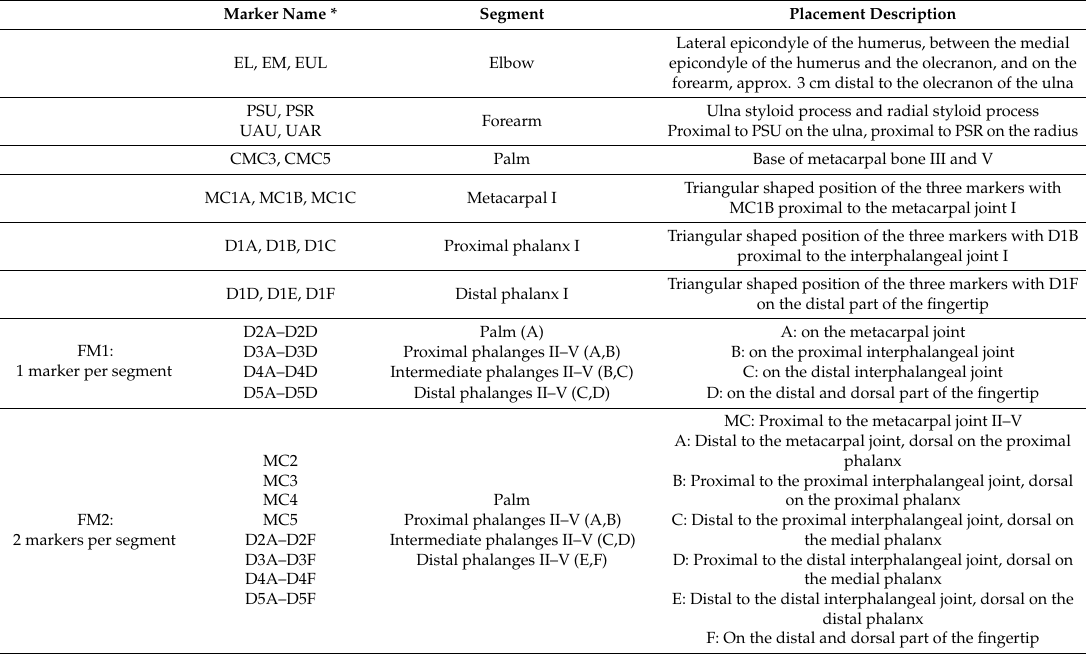
Table 1. Name and Location of the